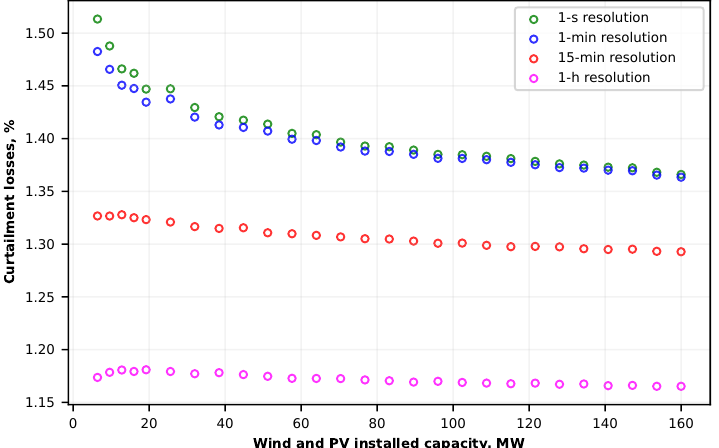
Figure 14. Curtailment losses in % of total HPP production, calculated in 1 h, 15 min, 1 min, and 1 s time resolution. HPP is composed of 50% wind and 50% solar capacity, while grid cut-off power is 70% of HPP